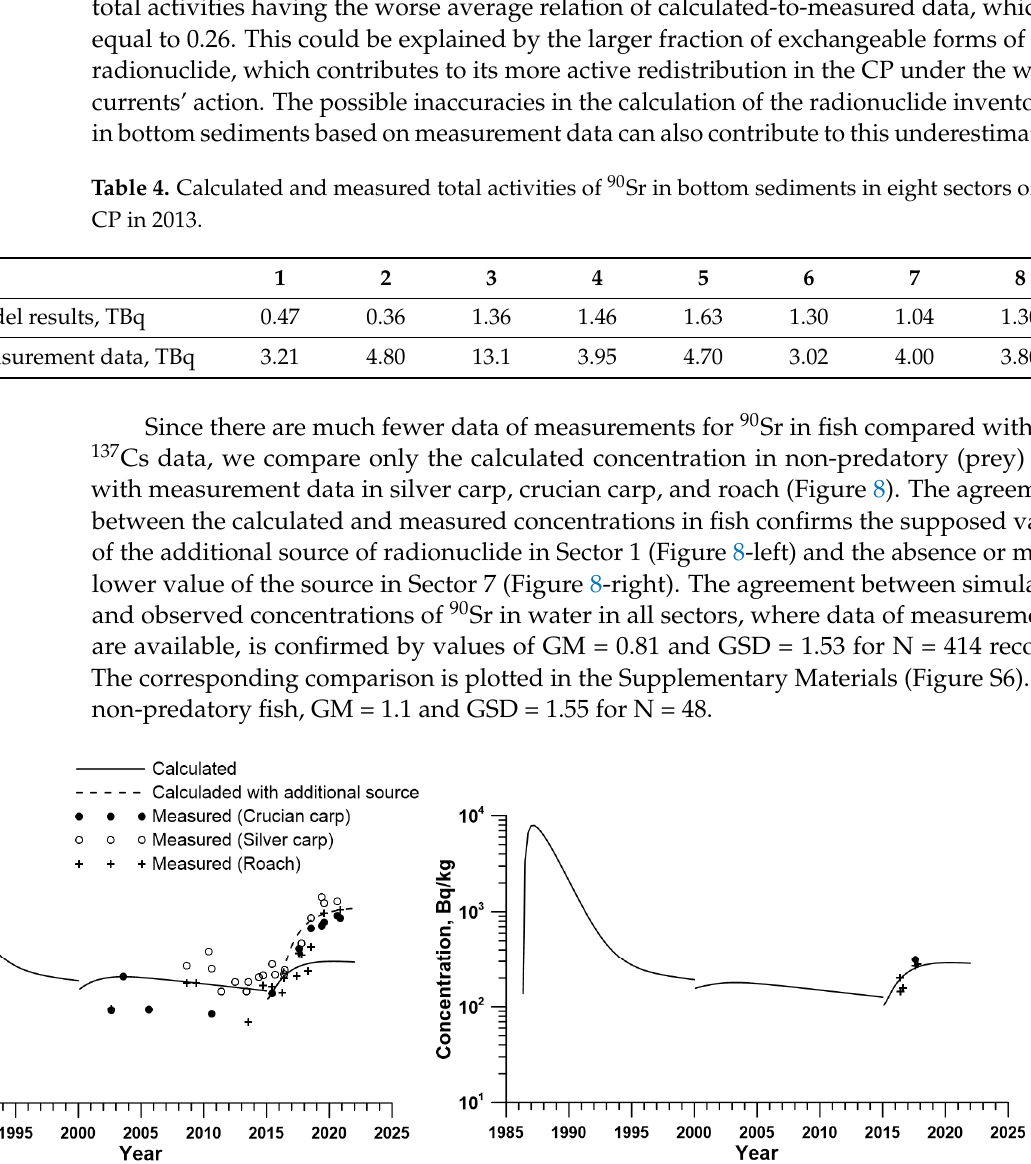
Figure 8. Comparison of calculated and measured concentrations of 90 Sr in non-predatory (prey) fi sh in Sector 1 (left) and Sector 7 (right) of the